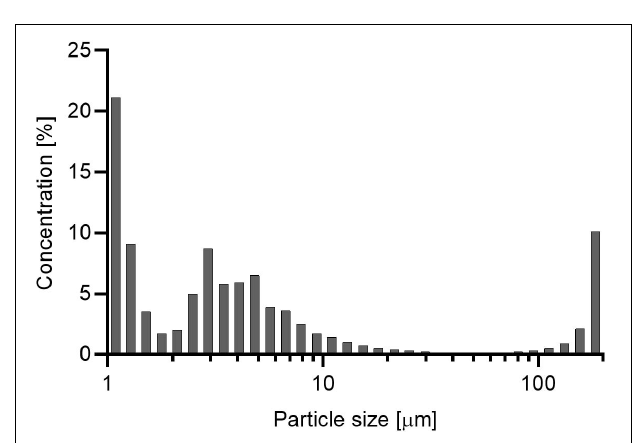
FIGURE 6 | Percentage of concentration per size class of the suspended sediment in end-concentration. 73% of suspended particles are represented in the size class from 1 to 6 µ